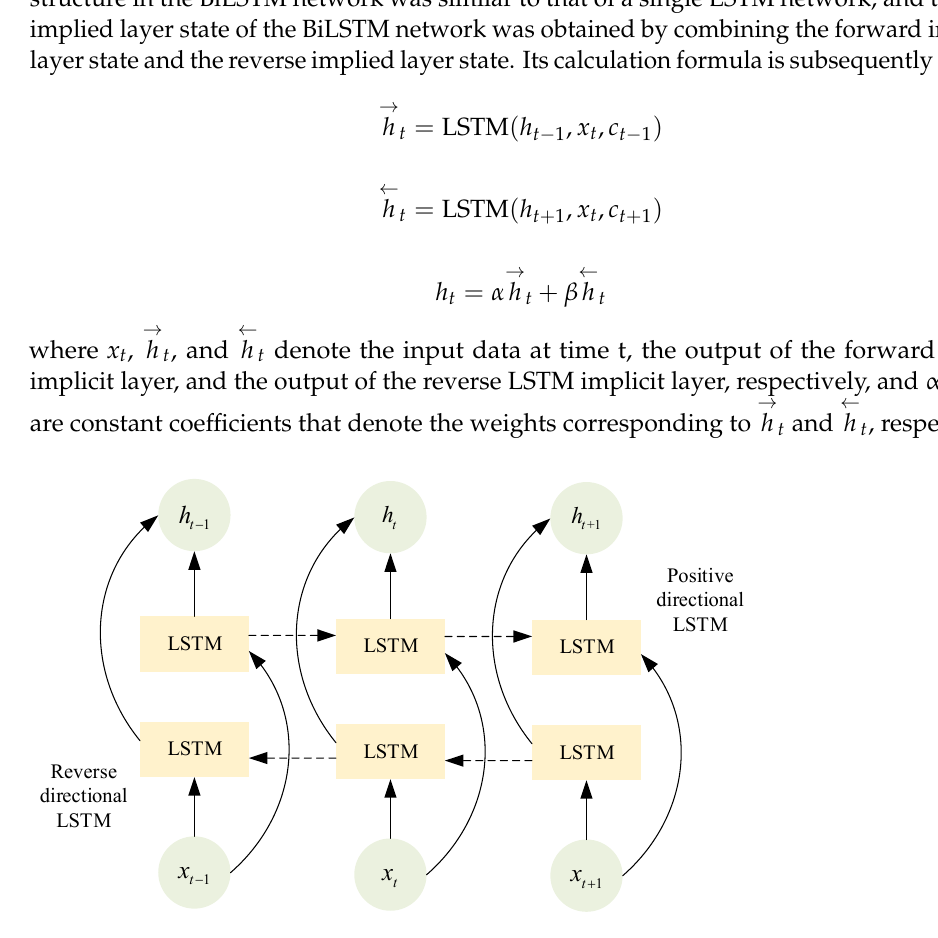
Figure 2. The BiLSTM network structure diagram.